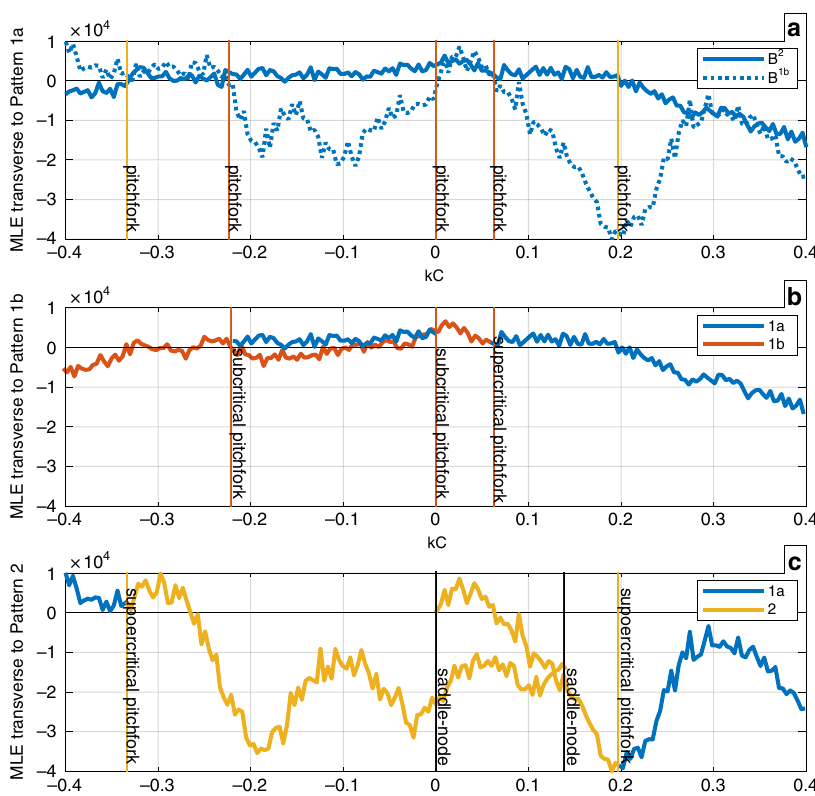
Fig. 5 Stability of different cluster synchronization patterns. a MLEs transverse to solution 1a. Solid and dotted lines refer to different transverse blocks. When a line crosses zero it identi fi es a symmetry-breaking bifurcation in one of the other invariant manifold (red: bifurcations on CS manifold 1b — yellow: bifurcations on CS manifold 2). Pattern 1a is stable when both the curves are negative. b MLEs transverse to stable solutions on the synchronized manifold 1b. Blue curves refer to the transverse MLE of solution of kind 1a, while the red curve refers to the transverse MLE of solution of kind 1b. Vertical lines indicate the bifurcations of the quotient system. c MLEs transverse to stable solutions on the synchronized manifold 2. Blue curves refer to the transverse MLE of solution of kind 1a, while the yellow curves refer to the transverse MLE of solution of kind 2. Vertical lines indicate the bifurcations of the quotient system. Colored lines represent symmetry breaking bifurcation (inferred from ( a )), while black lines are other